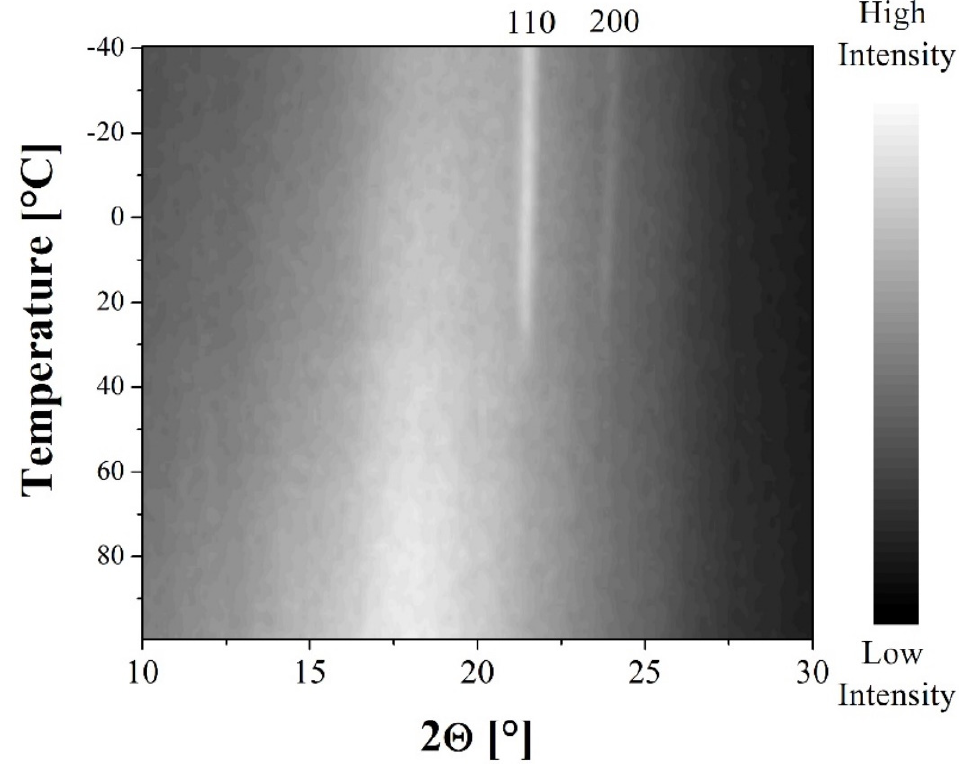
Figure 4. Time–temperature resolved synchrotron WAXD patterns during cooling at 10 ◦ C/min from 100 to − 40 ◦ C for bitumen A. Darker regions correspond to lower scattering intensities while the 110 and 200 reflections are labelled accordingly.